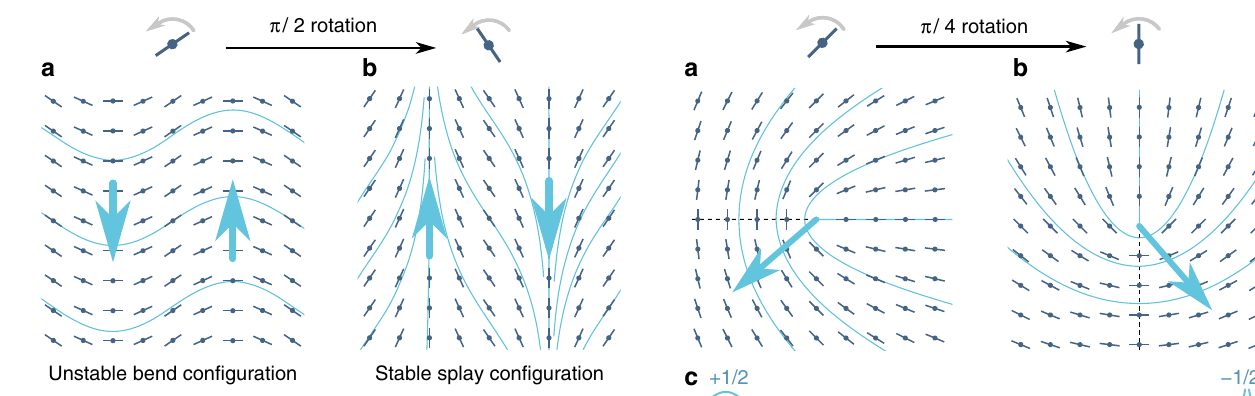
Fig. 1 Stabilisation of the ordered phase due to the autonomous rotation of chiral particles. a The achiral force ζ ∇ · Q (blue arrows) destabilises a bent con fi guration by inducing a torque that tends to enhance the distortion relative to a perfectly horizontally aligned state. b As the particles rotate by an angle π /2, however, the bent con fi guration is converted to a splayed con fi guration. This results in a reversal of the achiral force, which now suppresses the distortion. Depending on parameters, the superposition of these opposite trends may result in an overall stable system